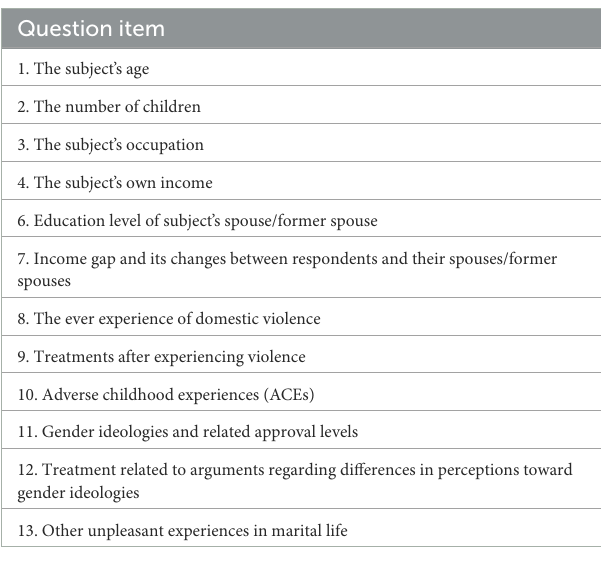
TABLE 1 Items included in the